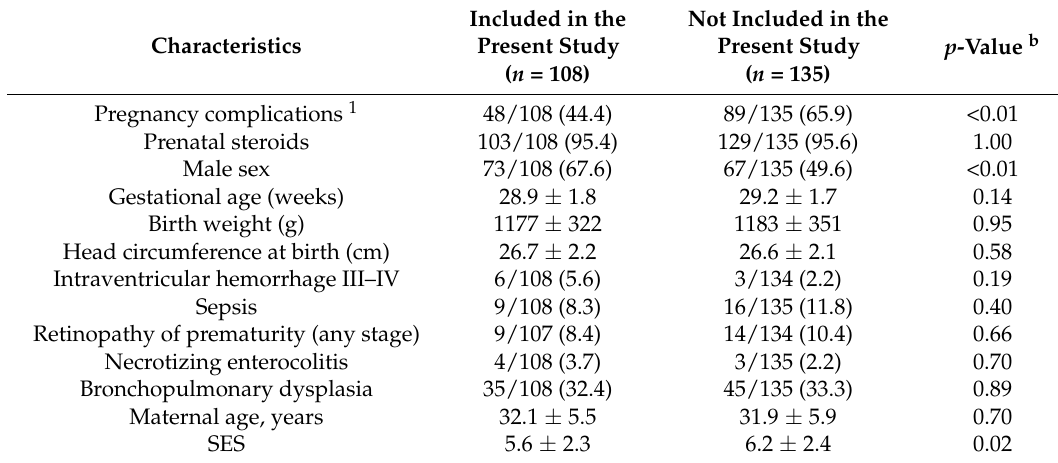
Table 1. Baseline characteristics and outcomes of all infants with FU5 by the end of